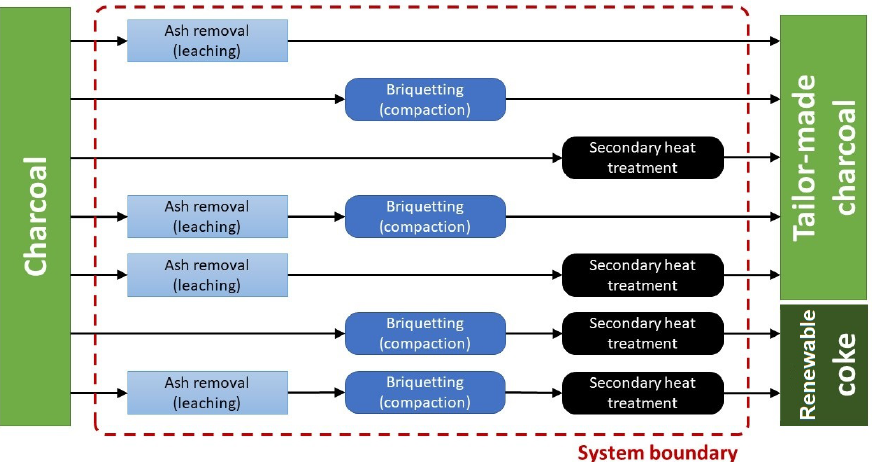
Figure 5. Investigated processes and process chains to produce tailor-made charcoal or renewable